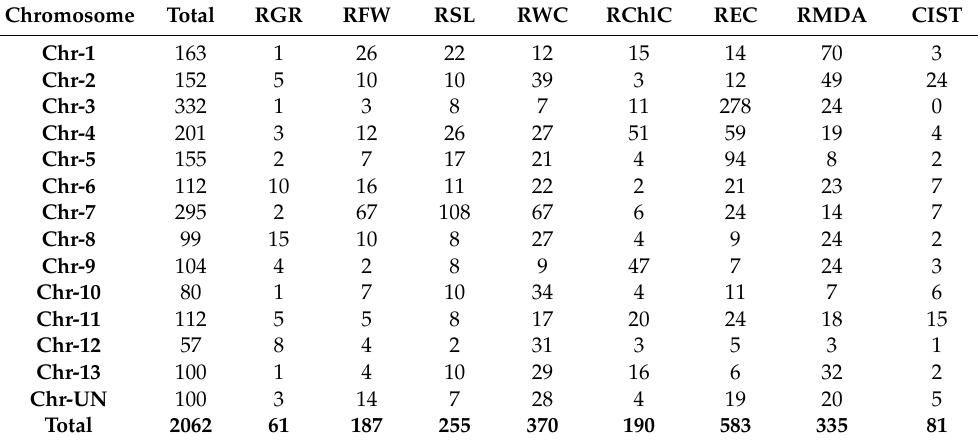
Table 3. Associated SNPs of di ff erent salinity traits distribution on chromosome